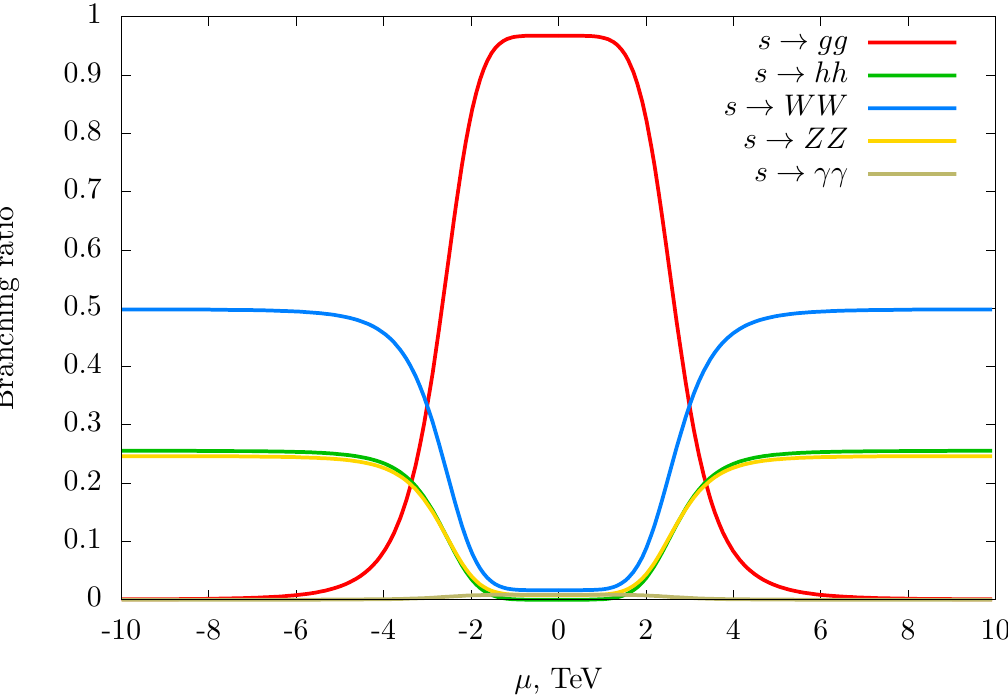
Figure 4. Branching ratios for sgoldstino decays in two gluons ( s gg , red line), two light neutral ! Higgs bosons ( s hh , green line), two W-bosons ( s WW , blue line), two Z-bosons ( s ! ! yellow line), two photons ( s (cid:13)(cid:13) , brown line) versus parameter (cid:22) . Here the model !